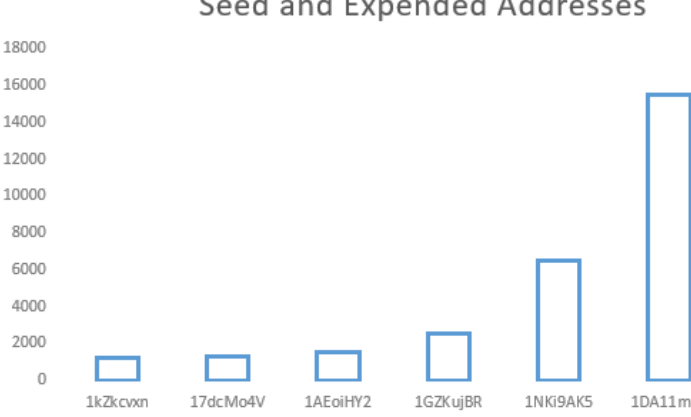
Figure 16. The total of the financial damages generated per address type.